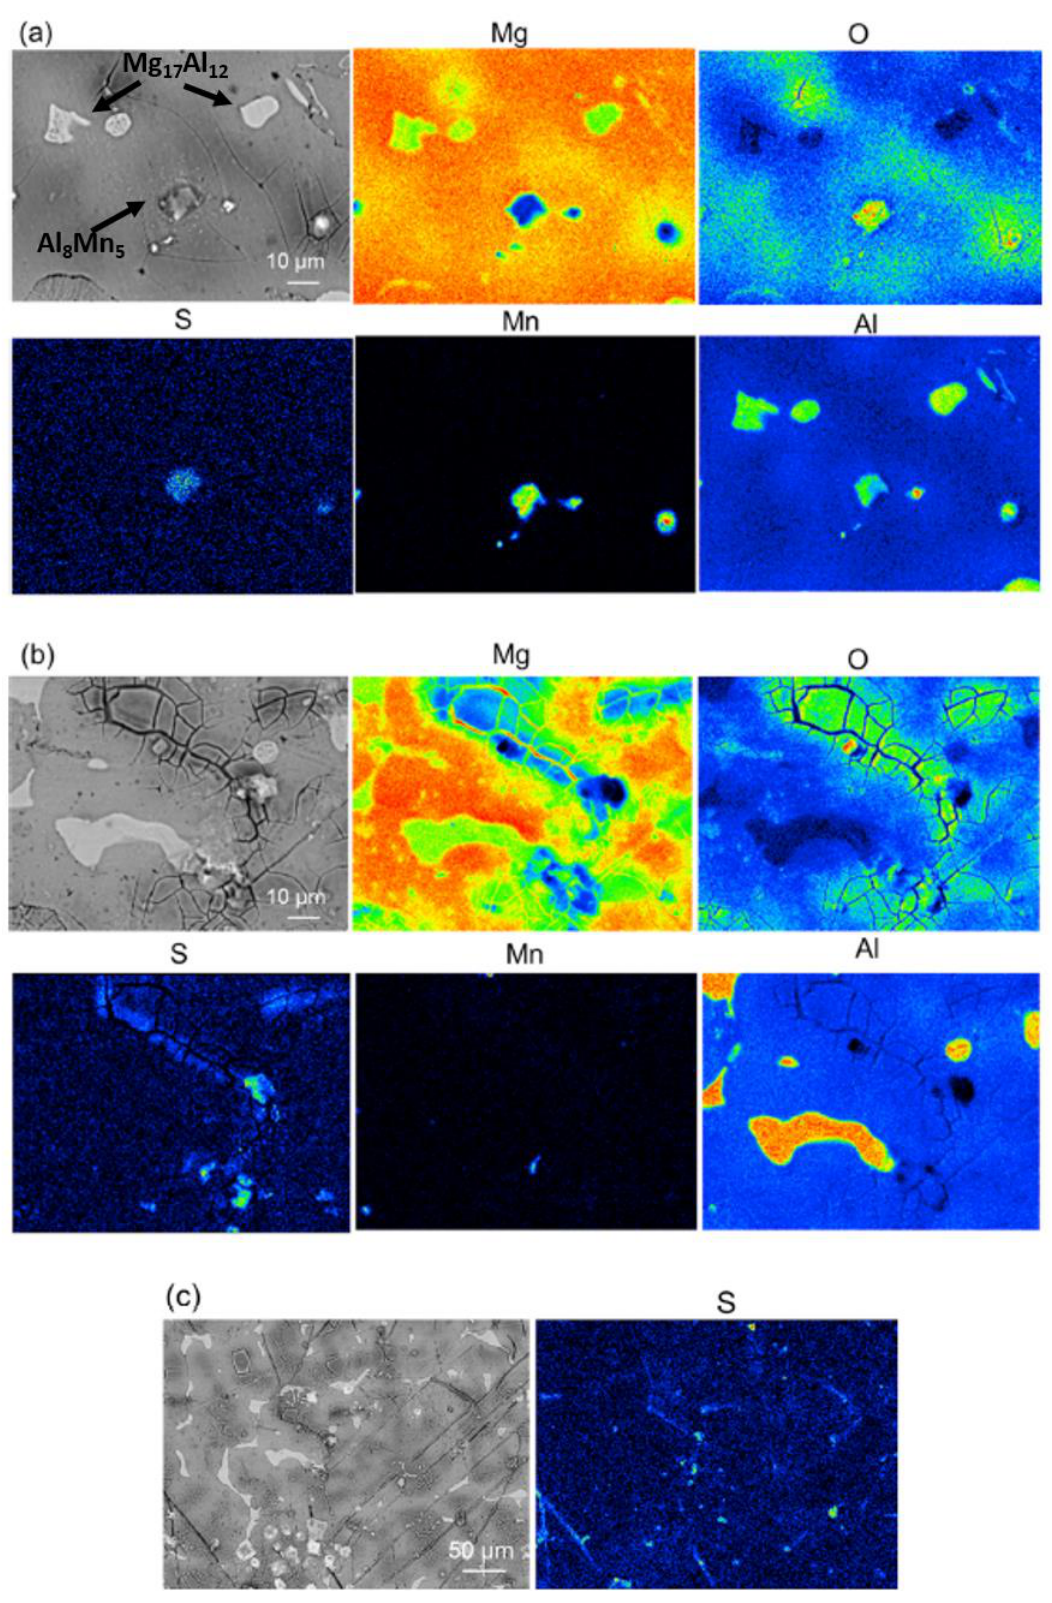
Figure 9. Main elemental distribution (Mg, O, S, Mn, and Al) on Mg surface after immersion for 6 h ( a ) and 48 h ( b , c ) in 3.5 wt.% NaCl solution with addition of 0.05M SDS. Adapted from [116] with permission from Elsevier.